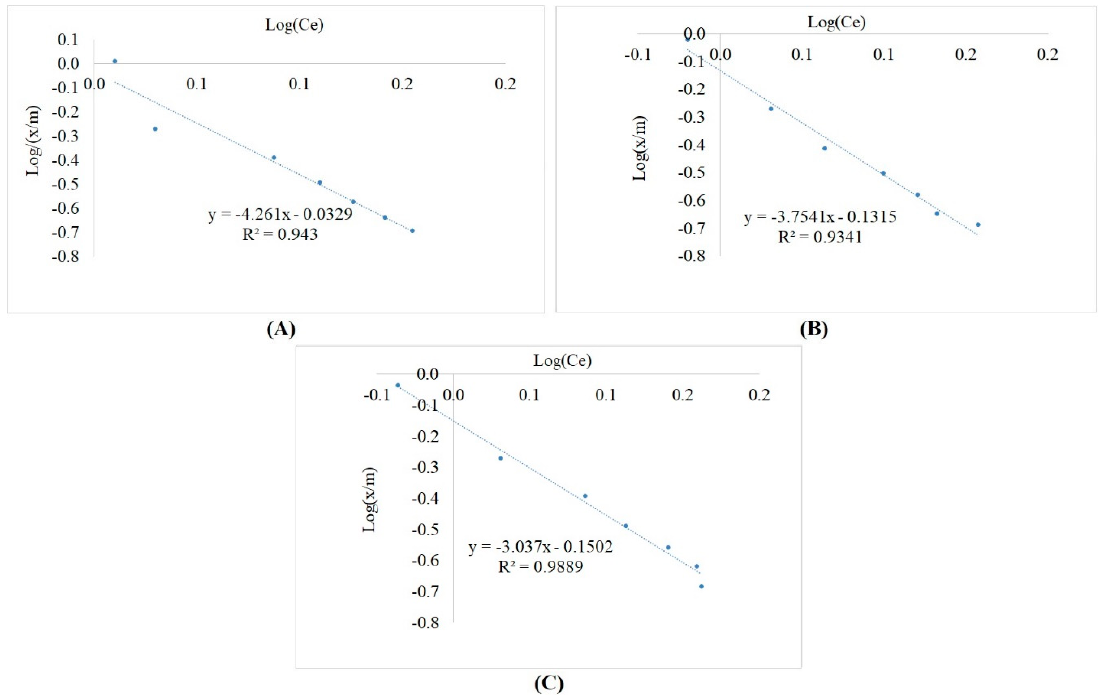
Figure 11. Freundlich isotherm regressions for diclofenac ( A ), ibuprofen ( B ), and naproxen ( C ).